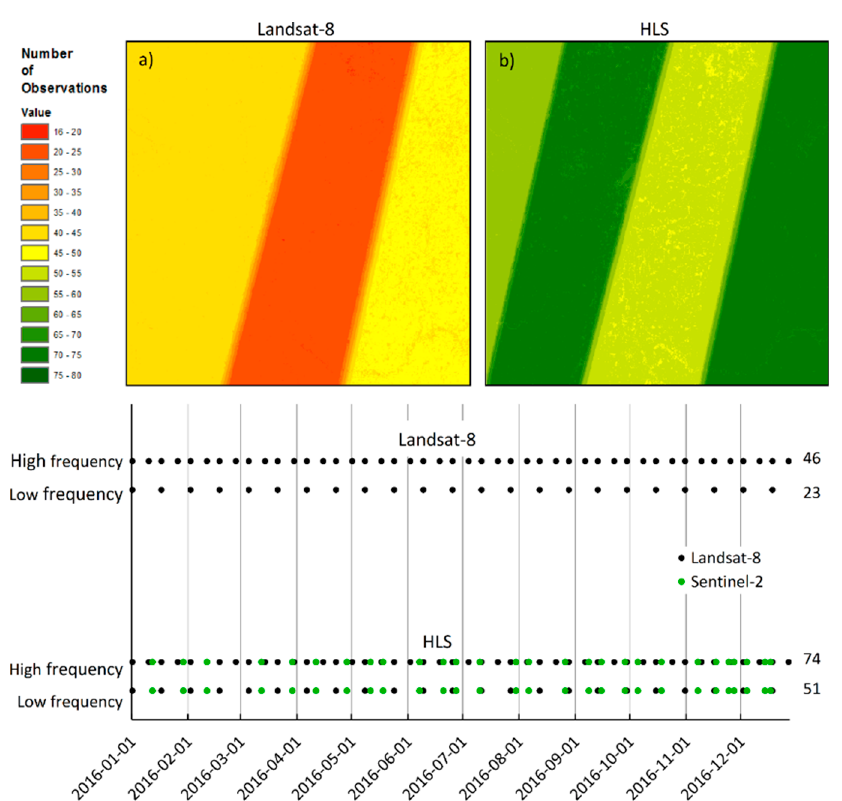
Figure 2. Images show the spatial distribution of valid (NDVI > − 0.1) observations for ( a ) Landsat-8 and ( b ) HLS at the phenology study site (14UPU). The scatterplot shows the temporal distribution of Landsat-8 and HLS observations for a high data frequency location (48°17’59.41”N, 96°19’37.56”W) and a low data frequency location (48°18’34.01”N, 96°46’42.88”W) in 2016. The values listed on the right side of the plot are the total number of observations, including observations with cloud contamination.